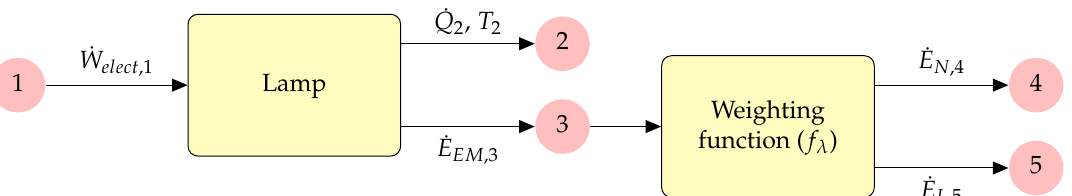
Figure 4. A lamp that uses electricity at 1 to produce heat at 2 , broad-spectrum EM radiation at 3 , non-light EM radiation at 4 , and light at 5